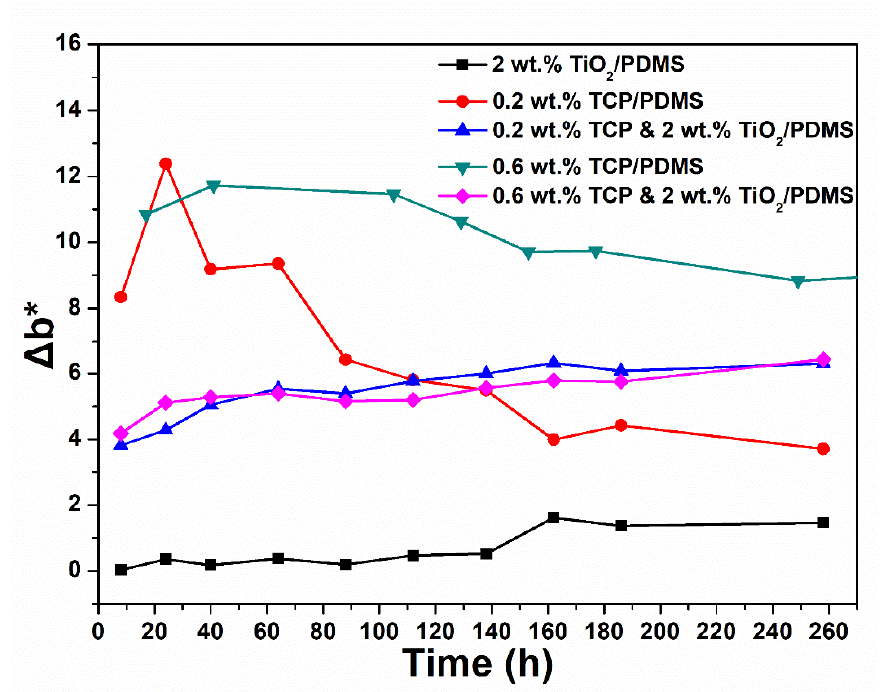
Figure 8. The yellow-blue character Δ b* as a function of time, during accelerated aging of silicone elastomers colored with TCP (0.2 and 0.6 wt%).